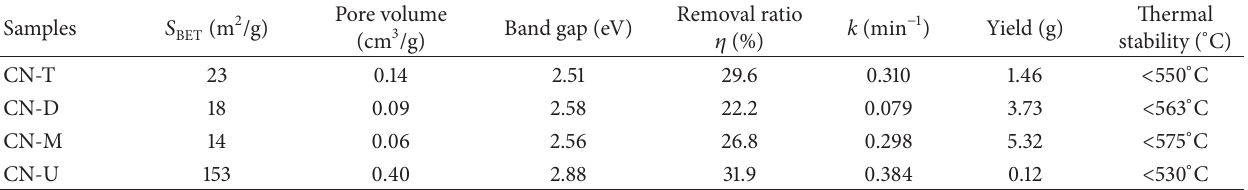
, pore volume, band gap, removal ration, initial rate constant 𝑘 , yield, and thermal stability of CN-T, CN-D, CN-M, and